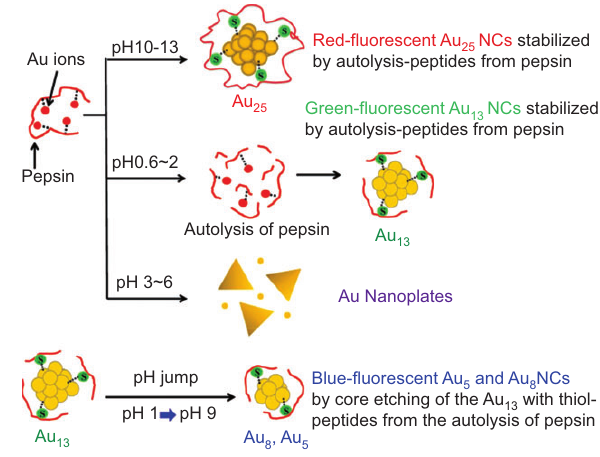
Figure 8 Schematic illustration of the pH-dependent synthesis of pepsin-mediated AuNCs with blue-, green-, and red-fluorescent emission. From Ref. [83]